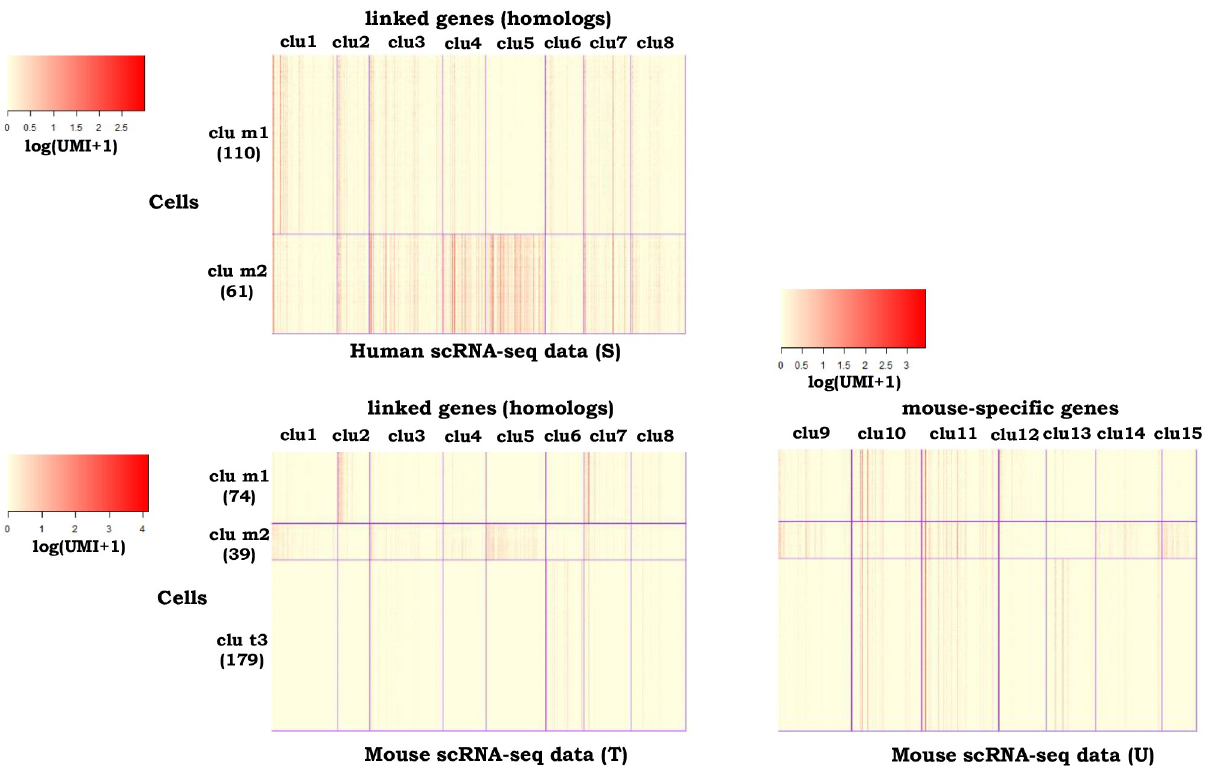
Fig 3. Heatmaps of the clustering results by couple CoC+ for example 2. “clu m” represents the matched cell cluster across the source data and the target data. “clu t” represents the cell cluster that is unique to the target data. For better visualization, we randomly averaged every 15 cells within the same cell cluster to generate pseudocells for every